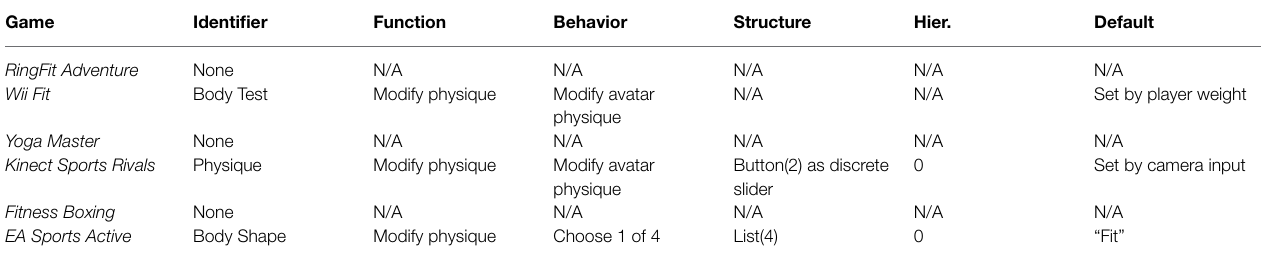
TABLE 2 | Avatar affordances data for Avatar Body.